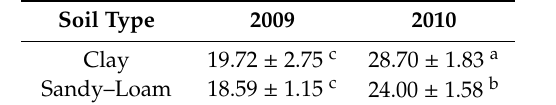
Table 4. Dry matter yield (t ha − 1 ) of the corn grown on clay and sandy-loam sites in 2009 and